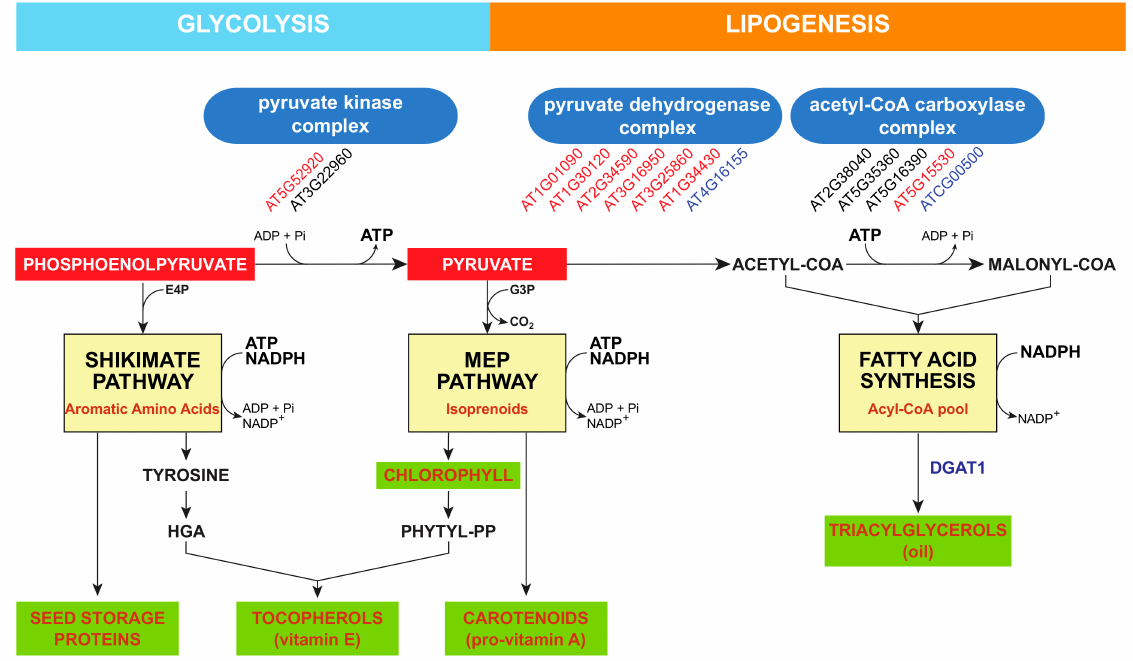
Figure 4. Plastidic intersection of the shikimate pathway, the methyl erythritol phosphate pathway, and lipogenesis. The shikimate pathway, methyl erythritol phosphate (MEP) pathway, and fatty acid synthesis are localized in plastids, and share phosphoenolpyruvate and pyruvate as common biosynthetic precursors. The biosynthesis of triacylglycerols occurs in the endoplasmic reticulum. Arabidopsis Genome Initiative numbers in red indicate that the corresponding gene is downregulated in Arabidopsis wri1 developing embryos, or upregulated in transgenic plants constitutively expressing the WRI1 transcription factor. AGI numbers in black indicate that the expression of the corresponding gene is WRI1-independent. AGI numbers in blue indicate that no transcriptomic data was